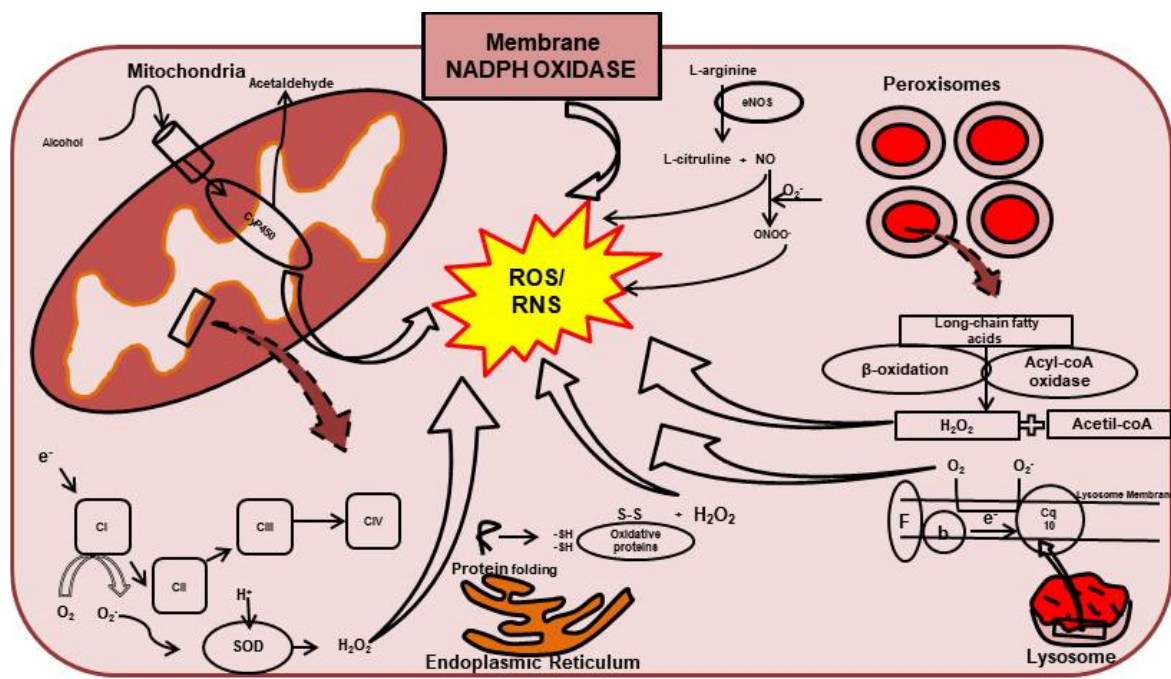
Figure 1. Schematic representation of ROS and RNS production by cell organelles and cell